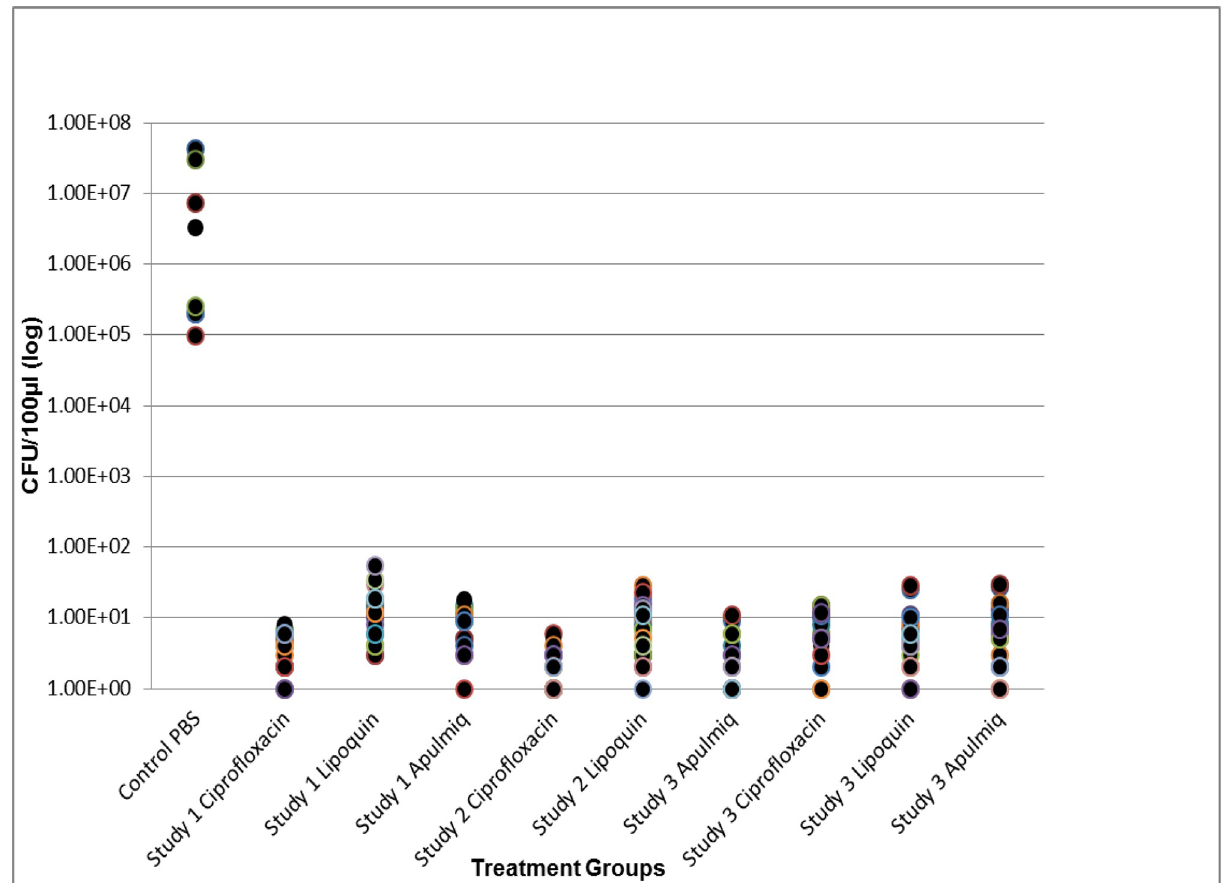
Fig 4. Bacterial load of lungs from surviving mice 30 days post therapy compared to lungs of treatment control mice (PBS) who succumb to infection. S1, S2, S3 refers to study number referenced in results. C is ciprofloxacin, A is apulmiq, and L is lipoquin. There was no significant difference in lung bacterial load between any treatment groups. All treatment groups were significantly different than PBS control group (p <